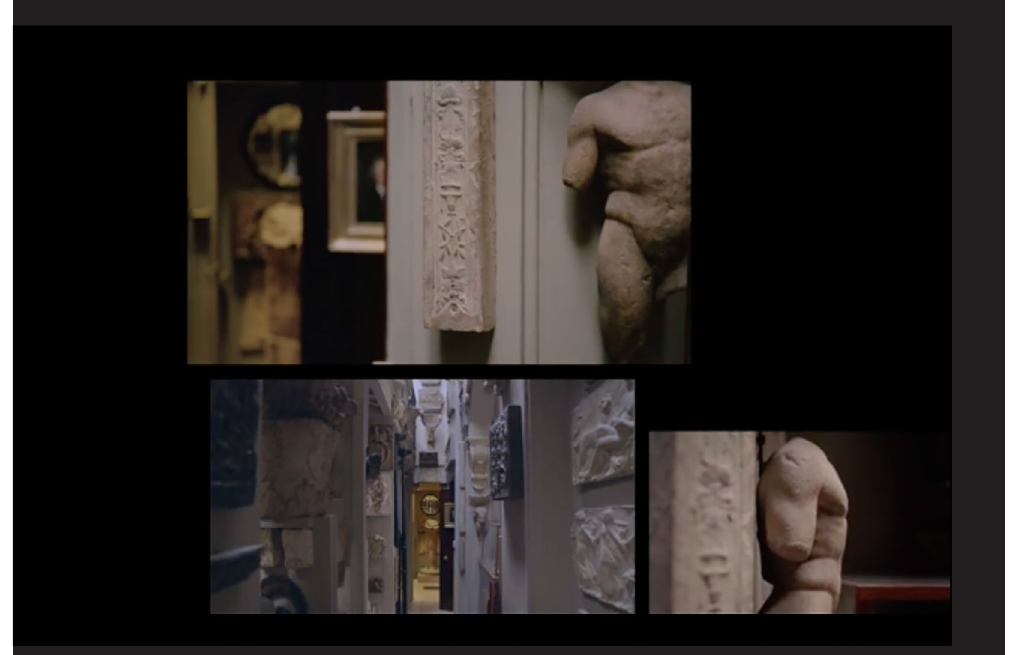
Fig. 5 The images of Inventory , through the simultaneous display of the elements of an accumulation of fragments of classical sculptures, represent the deepest soul of collecting: the desire to stop time. Courtesy of Fiona